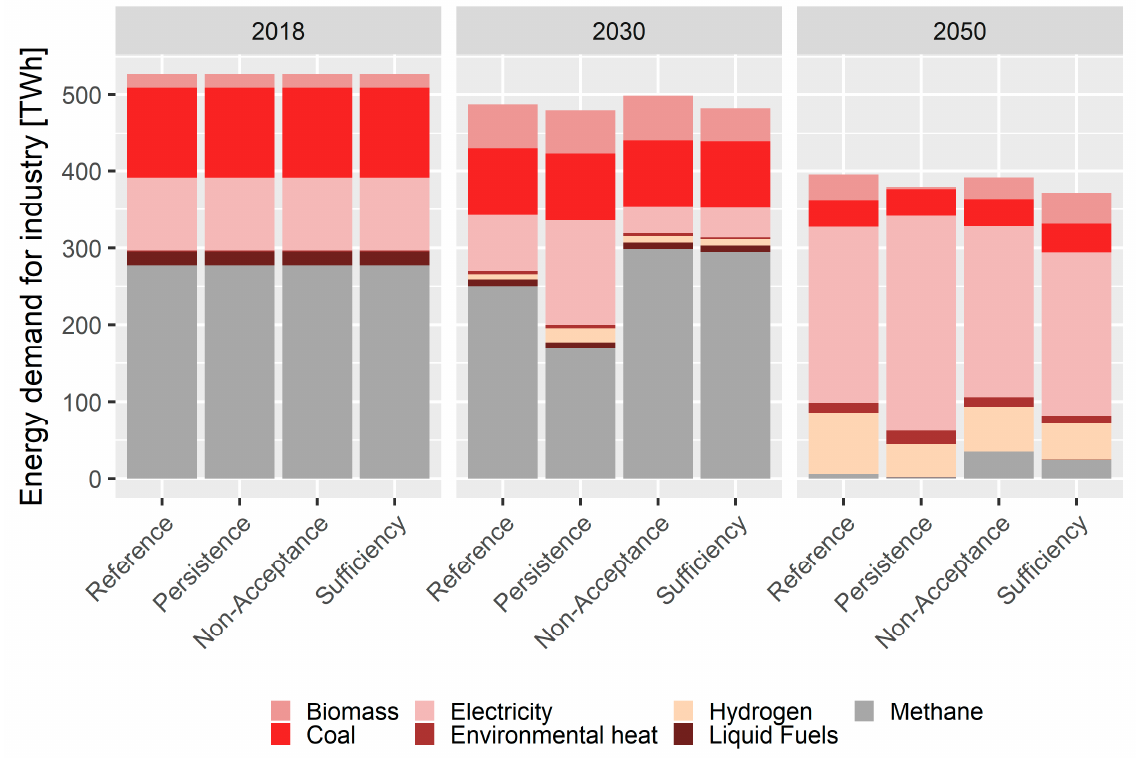
Figure 8. Present and future energy carrier mixes for process heating for the defined scenarios (results calculated with REMod).